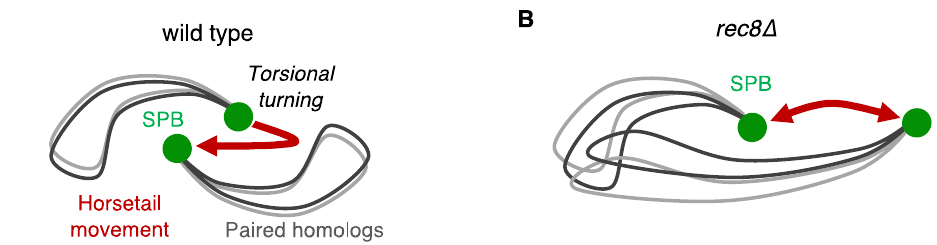
Figure 4. Horsetail nuclear movement in meiosis. Schematic diagrams of chromosome movement in wild-type ( A ) and rec8 ∆ ( B ) cells.